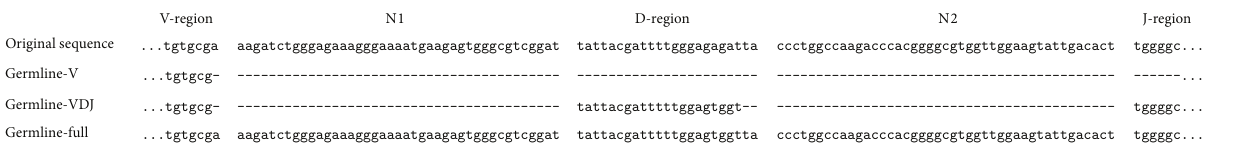
any codon position will be extended to cover the entire